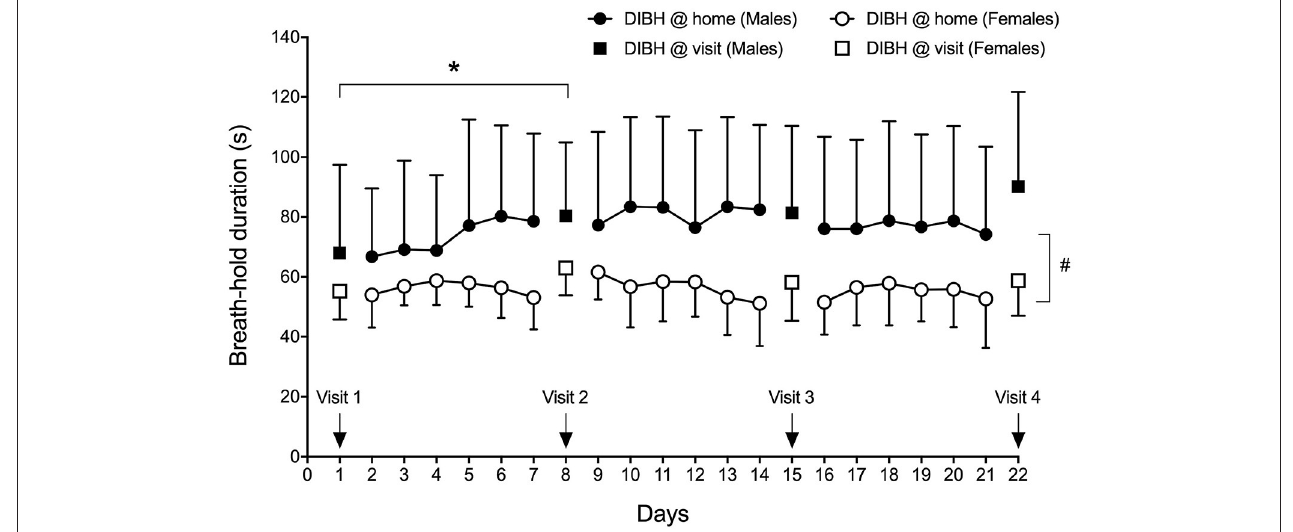
FIGURE 4 | Sex-specific group mean maximal DIBH durations ( ± standard deviation) at home and at visits. * p < 0.05; # p = 0.010.